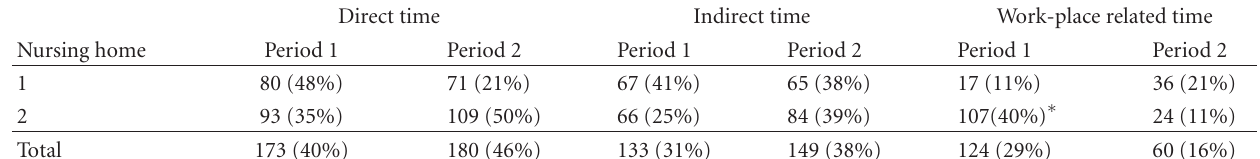
Table 3: Time in mean minutes/home between 6.45 AM to 9.15 P.M.